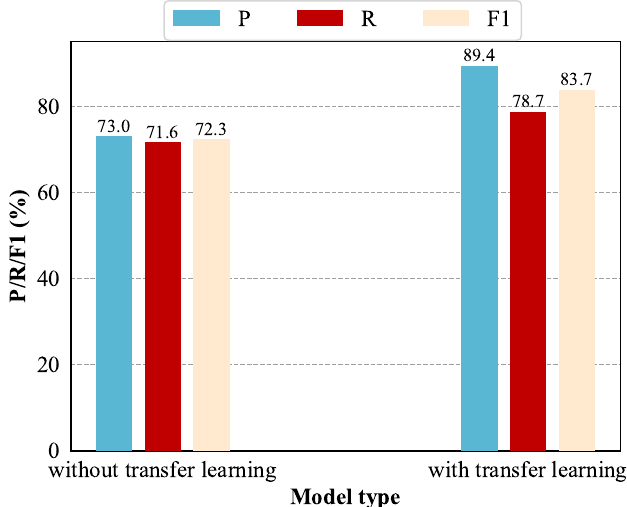
Figure 10. The impact of transfer learning on the model performance.